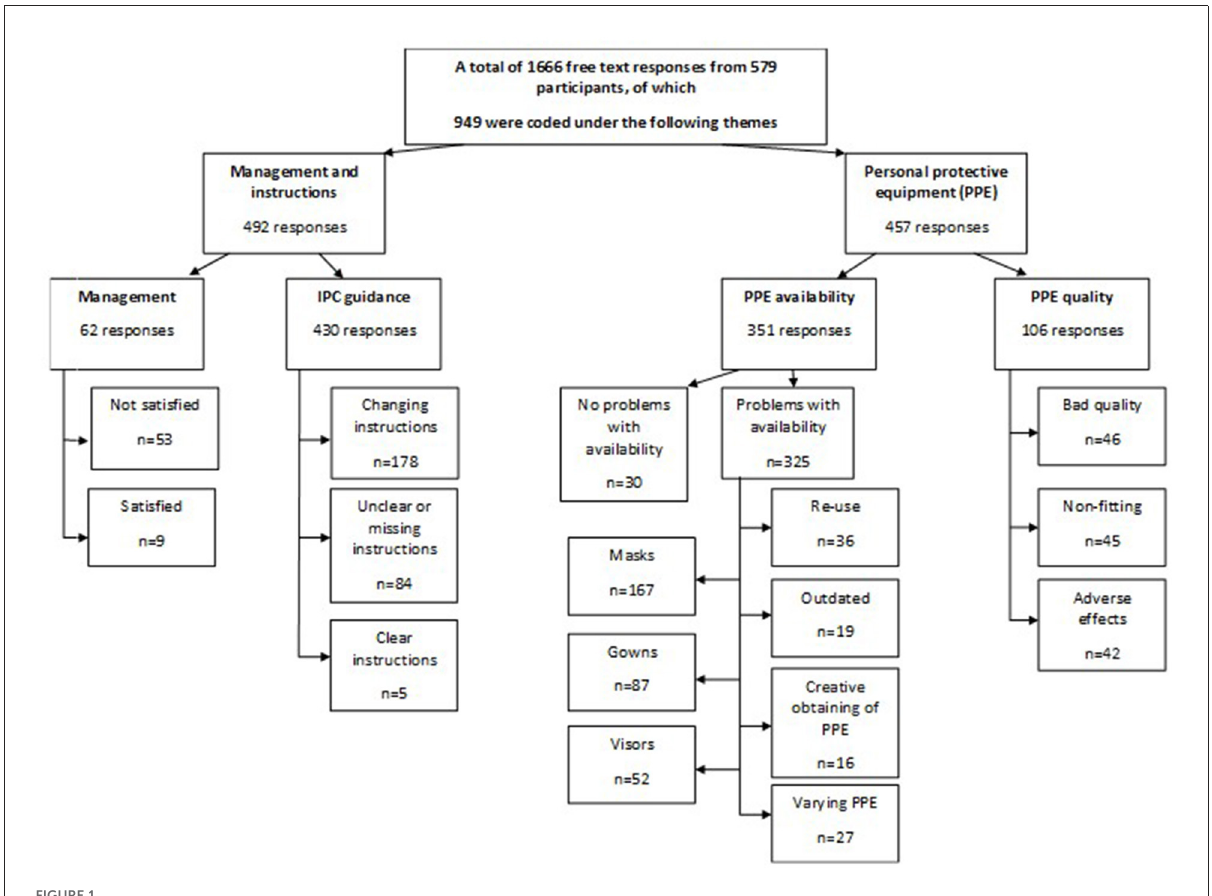
FIGURE1 Flow chart.